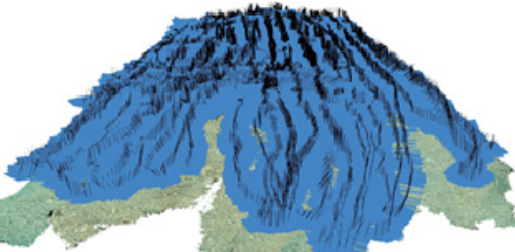
Figure 5: The aligned photos and the dense point cloud.